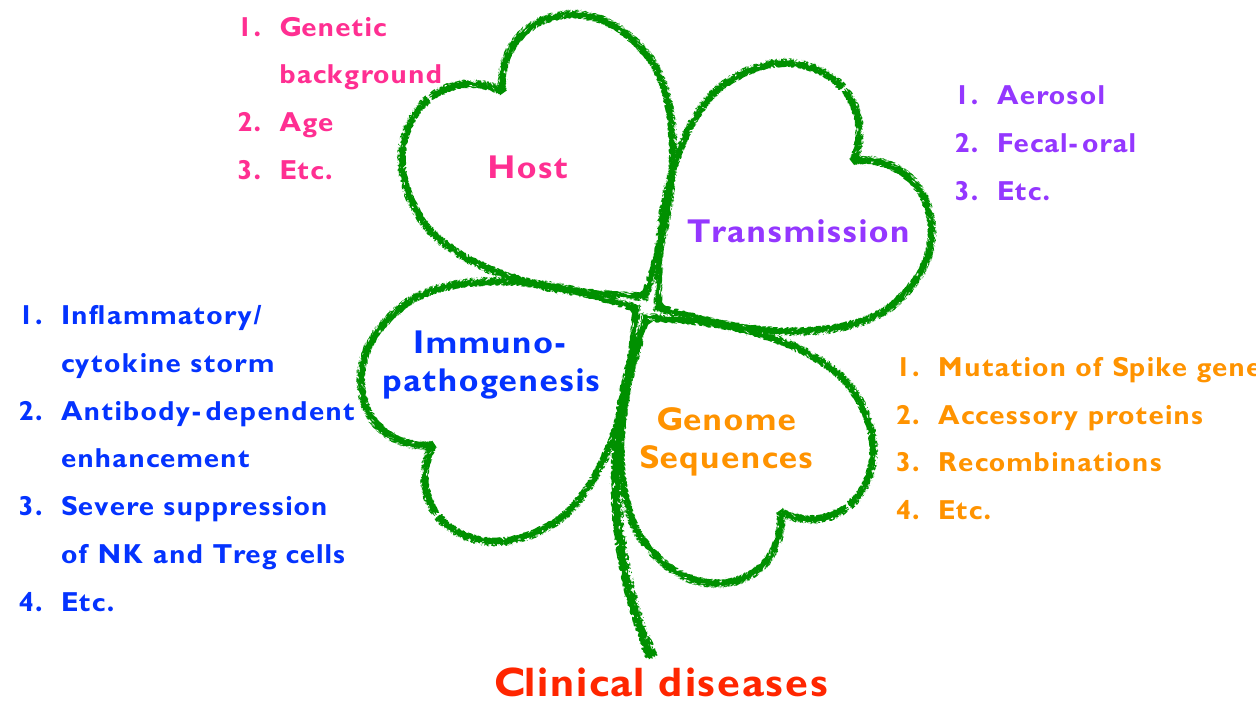
Figure 1. General summary of hosts, genome sequences, immunopathogenesis, and transmission features of animal coronaviruses that lead to clinical disease.